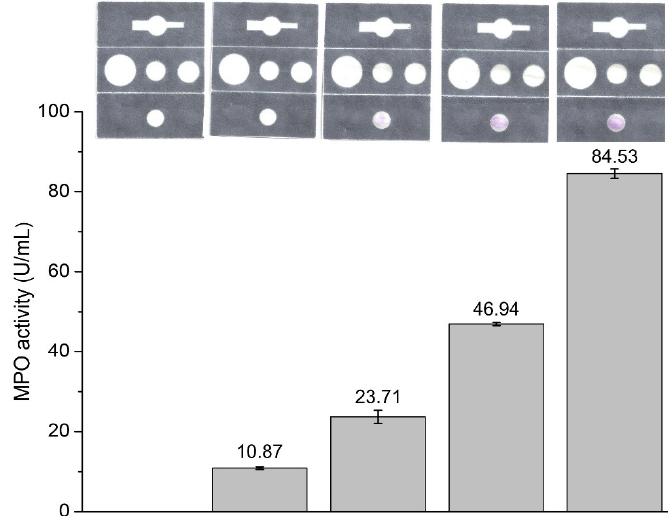
Figure 3. Fluidic paper device tested at different MPO activity (N = 5). Each sample was analyzed using the fluidic device (images) and spectrophotometrically (numerical values in U/mL of MPO in solution).